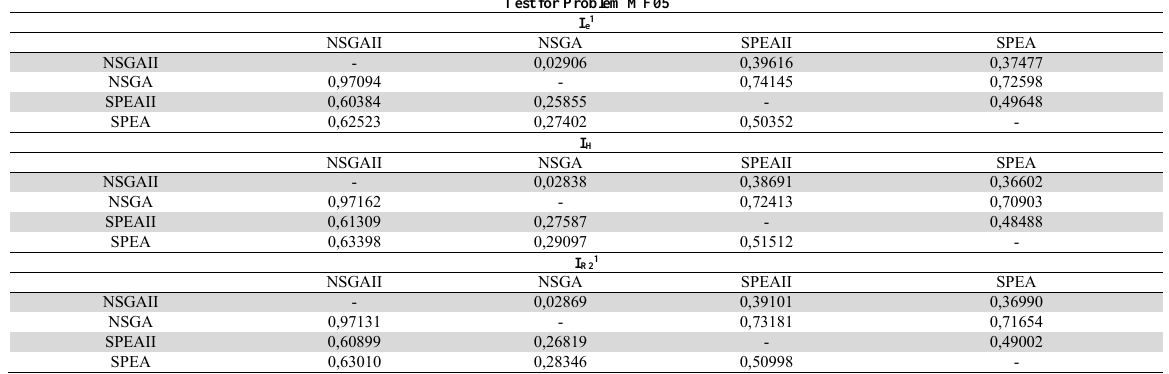
Unary epsilon indicator, unary hypervolume indicator and R indicator (MF05)